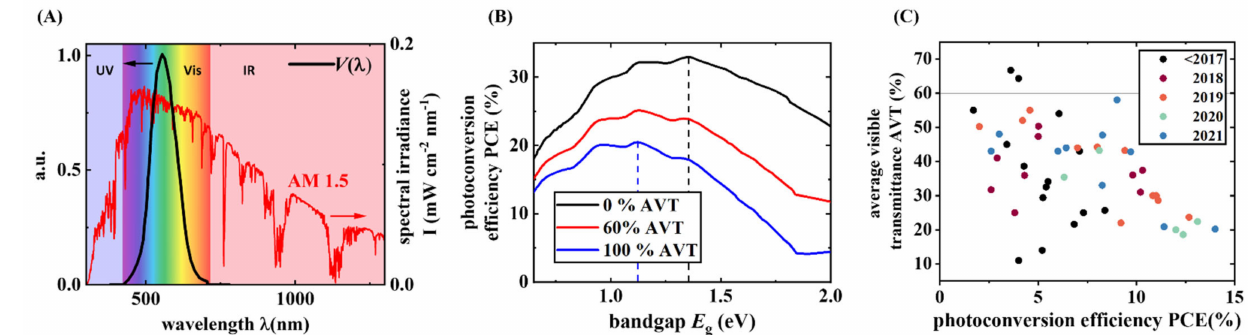
Figure 3. ( A ) Photopic response V ( λ ) of the human eye (left axis) and solar irradiance of the AM1.5 spectrum (red, right axis). ( B ) Theoretical PCE limit of ST-OPV single-junctions in dependence on the band gap for different AVTs, illustrating the required shift to narrower band gaps for more transparent OPVs. ( C ) Relationship of the AVT and the PCE of ST-OPVs reported in the